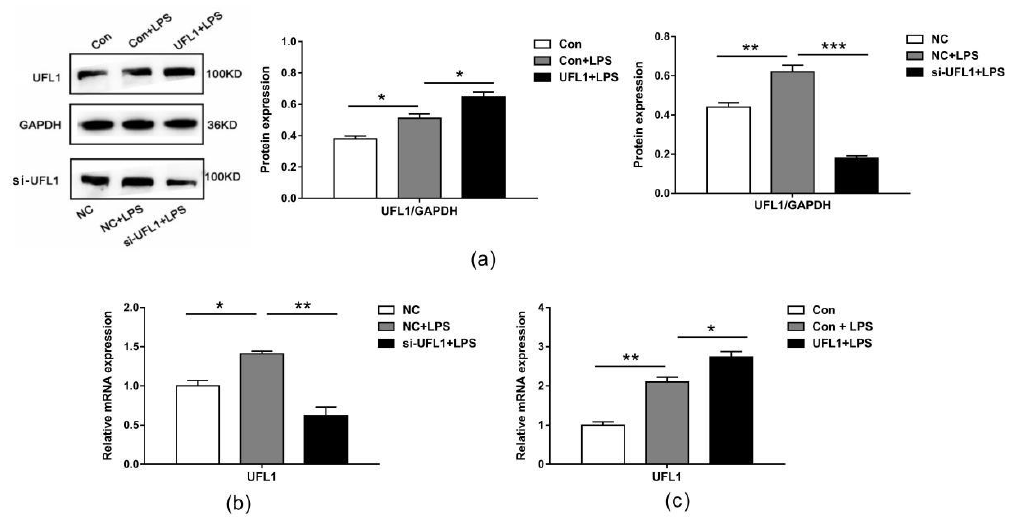
Figure 3. UFL1 is highly expressed in LPS-induced bGCs, and under LPS induction conditions, Ufl1 small-interfering RNA (siRNA) significantly reduced UFL1 mRNA and protein expression; overexpression of UFL1 significantly increased UFL1 expression. ( a ) Effect of LPS and UFL1 siRNA/UFL1 overexpression plasmid on the protein expression of UFL1 in bGCs. ( b ) qPCR analysis of Ufl1 in UFL1 siRNA-transfected bGCs stimulated with LPS. ( c ) qPCR analysis of Ufl1 in bGCs transfected with Ufl1 overexpression plasmid stimulated with LPS. Data are presented as the means ± the standard errors of the mean (SEM) of three independent experiments. ∗ p < 0.05; ∗∗ p < 0.01.